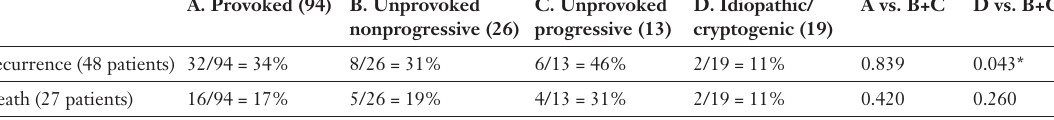
Relationship between aetiologies according to international defi- nition [29] and recur- rence and death, for the 152 patients who completed